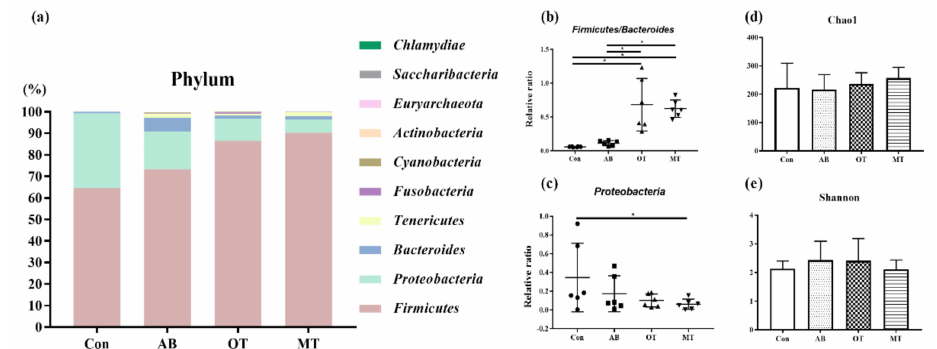
Figure 3. The high-throughput sequencing of 16S RNA in colonic feces of piglet. Con, the basal diet without antibiotics, tributyrin, oregano or methyl salicylate; AB diet, the basal diets supplemented with an antibiotic compound, which provides the diet with 120 mg oxytetracycline-calcium and 16 mg enduracidin per kilogram; OT and MT diets, the basal diet supplemented with tributyrin plus oregano (1.4 g and 0.6 g per kilogram diet) and tributyrin plus methyl salicylate (1.4 g and 0.6 g per kilogram diet), respectively. ( a ) Comparison of the phylum level between the 4 groups. ( b ) The relative ratio of the Firmicutes to Bacteroidetes . ( c ) The relative abundance of Proteobacteria . ( d ) Comparison of the abundance index (Chao1) between the 4 groups. ( e ) Comparison of the diversity index (Shannon) between the 4 groups. Error bars represent standard error of the mean. The p -values are based on Mann–Whitney tests. The statistical significance was the same when we used the unpaired t-test to log-transformed data. * Di ff erences were considered significant at p < 0.05 ( n = 6).